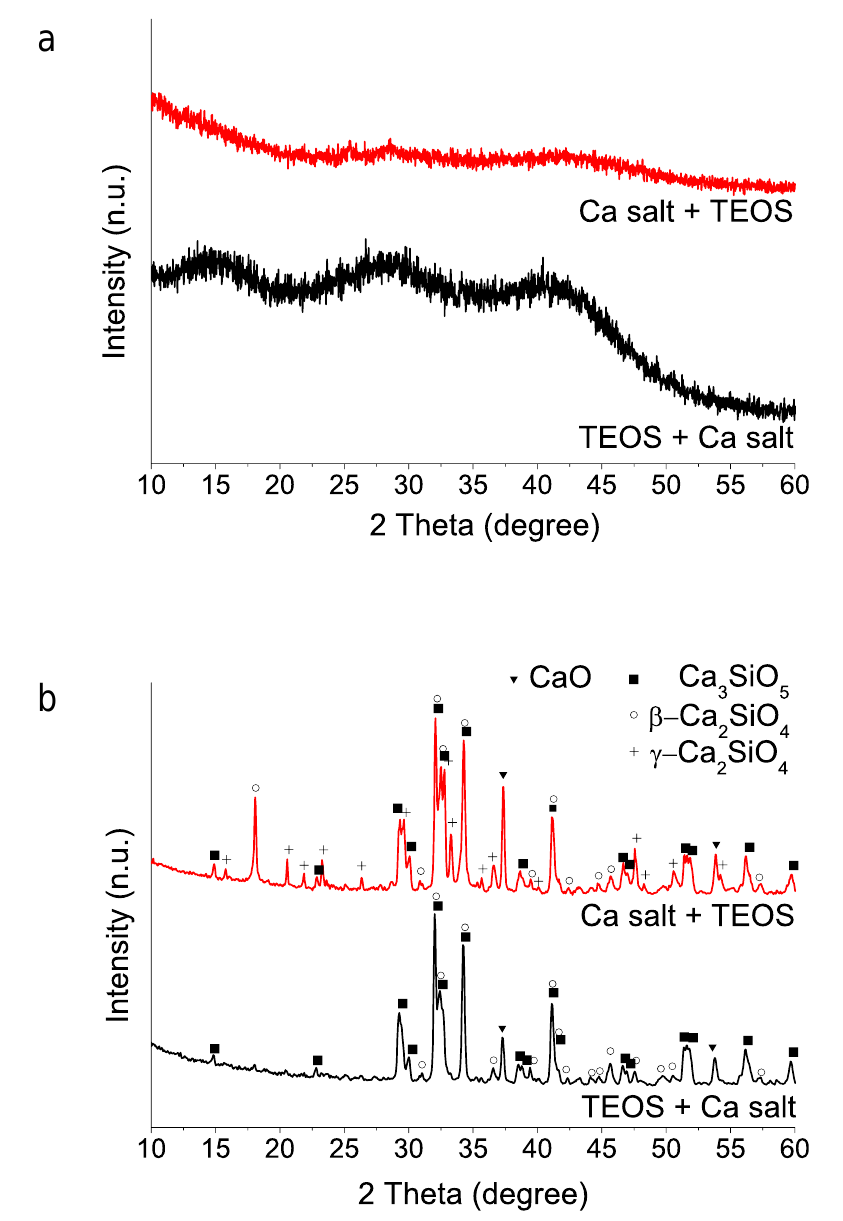
Figure 2. XRD patterns of sol – gel BEC preparations using different addition order of reagents: ( a ) as-synthesized powders (without heating treatment); ( b ) after heat treatment at 1400